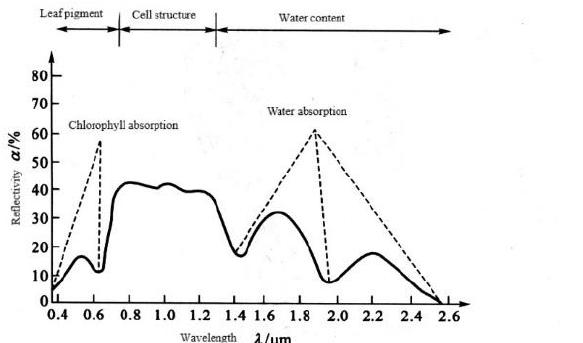
Figure 12. Spectral reflectance curves of healthy green plants